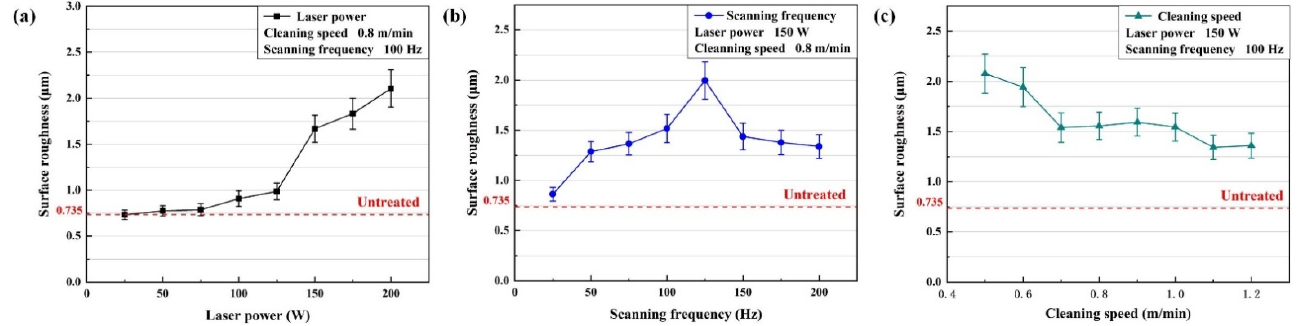
Figure 6. The variation of the surface roughness with the process parameters: ( a ) laser power; ( b ) scanning frequency; ( c ) cleaning speed.